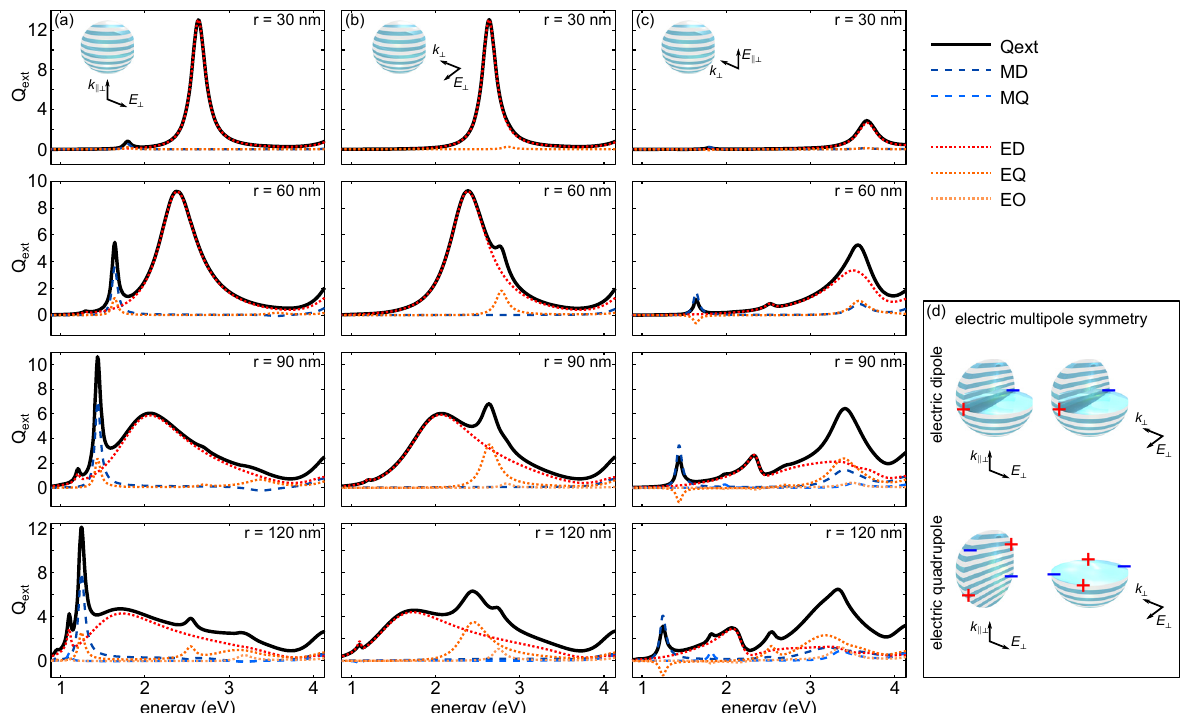
Figure 5: Spectra of total extinction efficiency (solid black line) and their decomposition into five moments MD, MQ, ED, EQ, and EO vs = 0 . 5) sphere radius. (a) For k illumination orientation and hyperbolic ( f ∥ (TEM polarization) for small r the ED is dominant, but with m increasing r a very sharp MD appears which is coupled with the EQ. However, higher electric multipoles remain weak even for r = 120 nm, while an additional ED appears below the MD. (b) For k ⊥ and E ⊥ (TE ⊥ polarization) the spectra evolve with r as those of a pure metallic nanosphere with first a dominant ED, followed by a stronger EQ for r = 90 nm, and then an EO. The MD, which is present in case (a) is absent here. (c) For k ⊥ and E ∥ (TM ⊥ polarization) the spectrum is of smaller amplitude and qualitatively different. The MD peak is at the same spectral location as for case (a), but couples out-of-phase to the EQ. The electric multipoles below 3 eV grow gradually with r . Interestingly, the peak above 3 eV is composed of a mix of all multipoles with higher orders appearing with increasing r . (d) Induced electric multipoles for TEM and TM ⊥ polarizations exhibit different symmetry in relation to the anisotropy axis, illustrating the same response of the ED mode and different response of the EQ